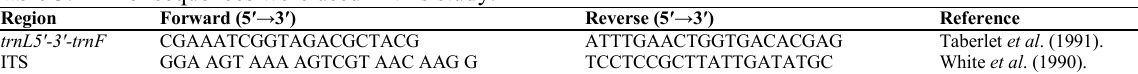
Taberlet et al . (1991).